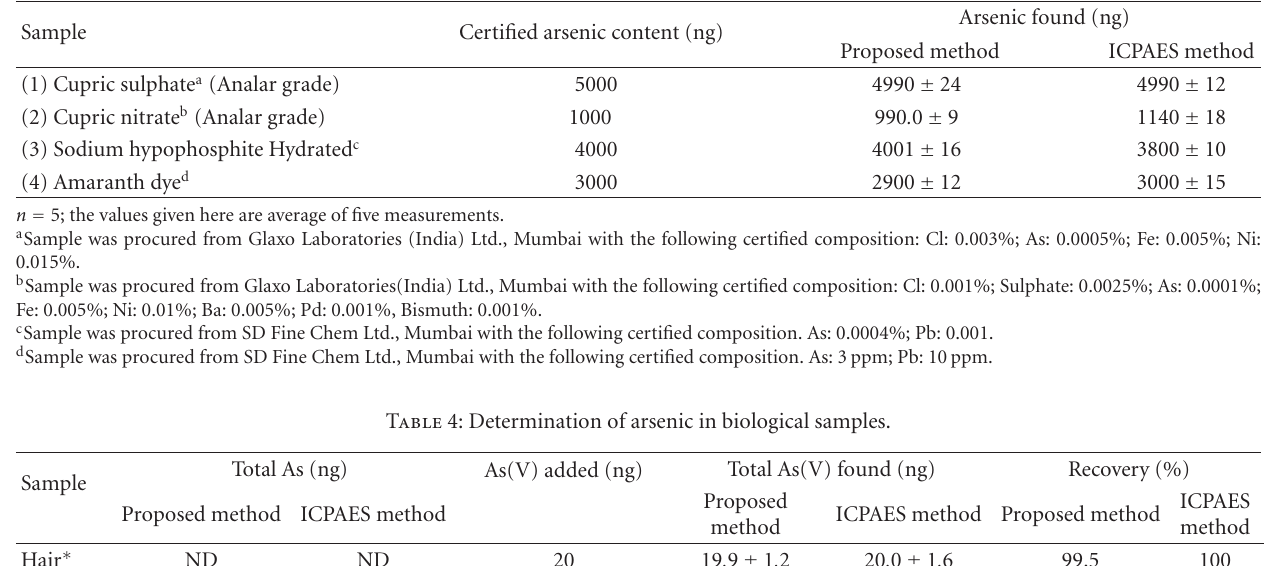
Table 3: Determination of arsenic from commercially procured chemicals.